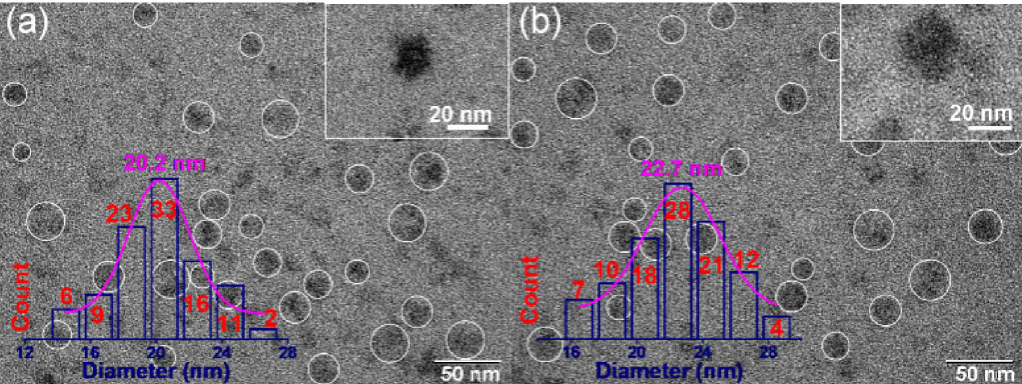
Fig. 2 TEM images of (a) CNPs-Na and (b) CNPs-Cl. Insets: TEM images of single particles and particle size distribution